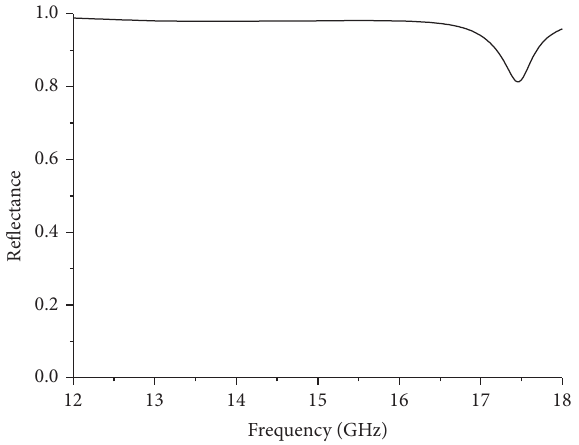
Figure 11: The total reflection amplitude.